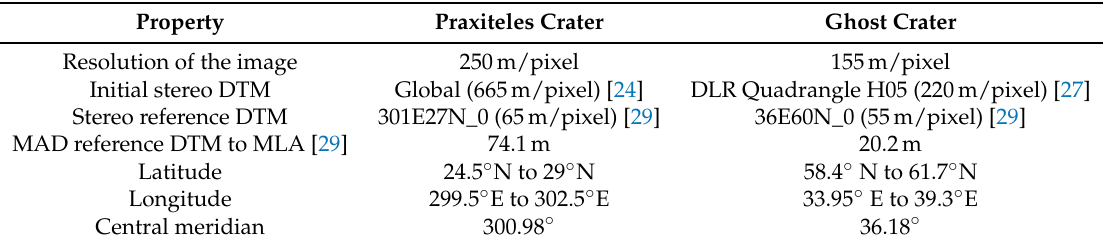
Table 4. Properties of the DTMs and original images used for the first evaluation method.